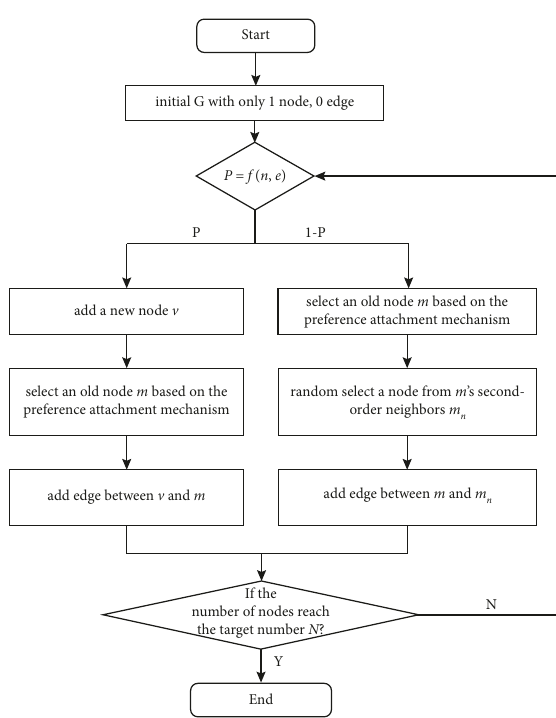
Figure 7: Degree distribution and fitting results.